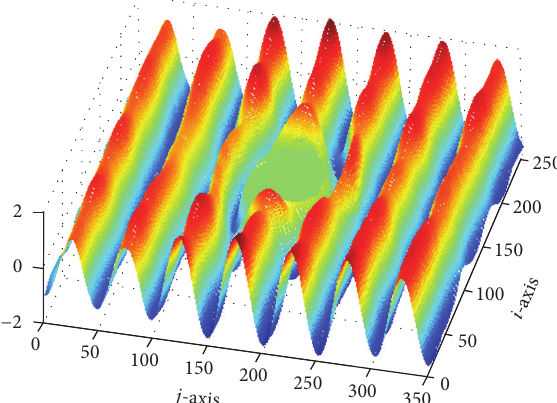
Figure 3: Three-dimensional field distribution plot for a 2GHz sine wave with no object in its path.